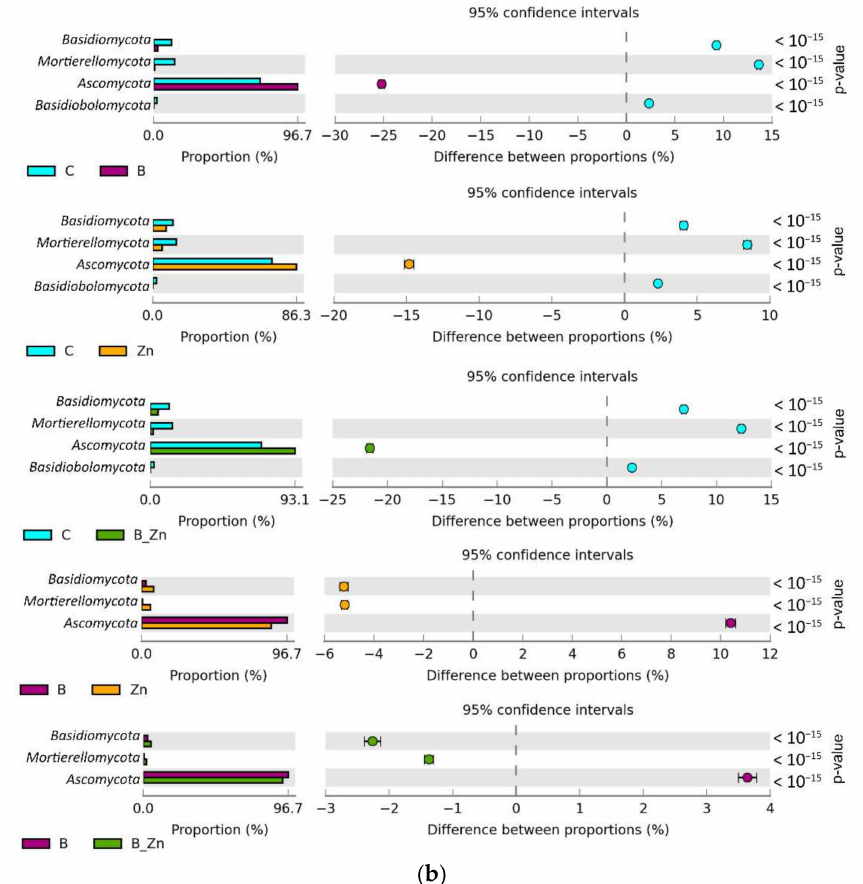
Figure 8. Relative abundance of the dominant types of bacteria ( a ) and fungi ( b ) in the soil, with a difference between proportions ≥ 1%; C—uncontaminated soil; B—bisphenol A; Zn—ion zinc (Zn 2+